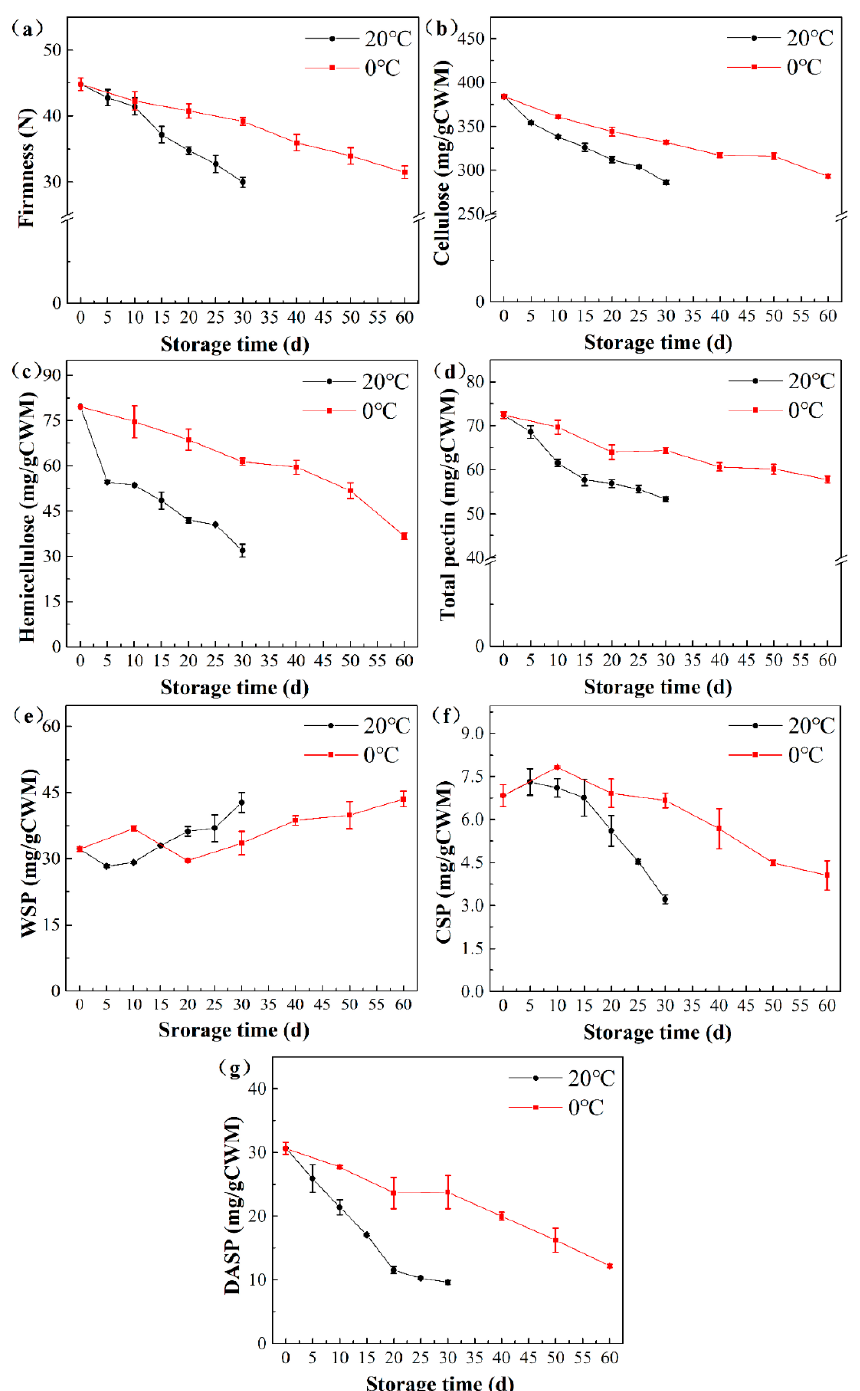
Figure 1. Changes in firmness ( a ) and content of cellulose ( b ), hemicellulose ( c ), total pectin ( d ), and three fractions of pectins (WSP ( e ), CSP ( f ), DASP ( g )) for the peach of ”Zhonghuashoutao” cultivar stored at 0 °C and 20 °C. The hemicellulose content was reflected by the xyloglucan content, which was determined by measuring the glucose content using the anthrone method. The bars represent standard.